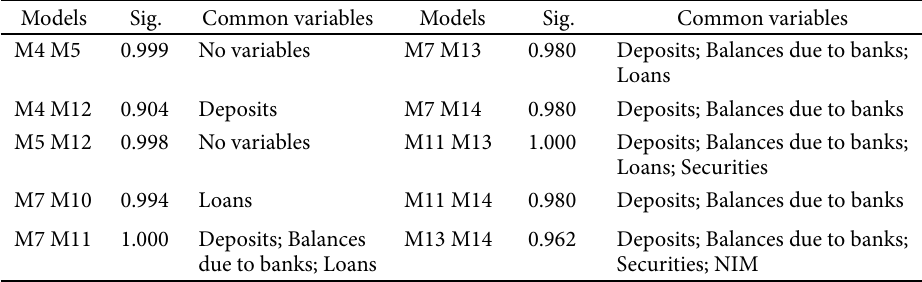
Table 11. The results of Kolmogorov-Smirnov two-sample test Models